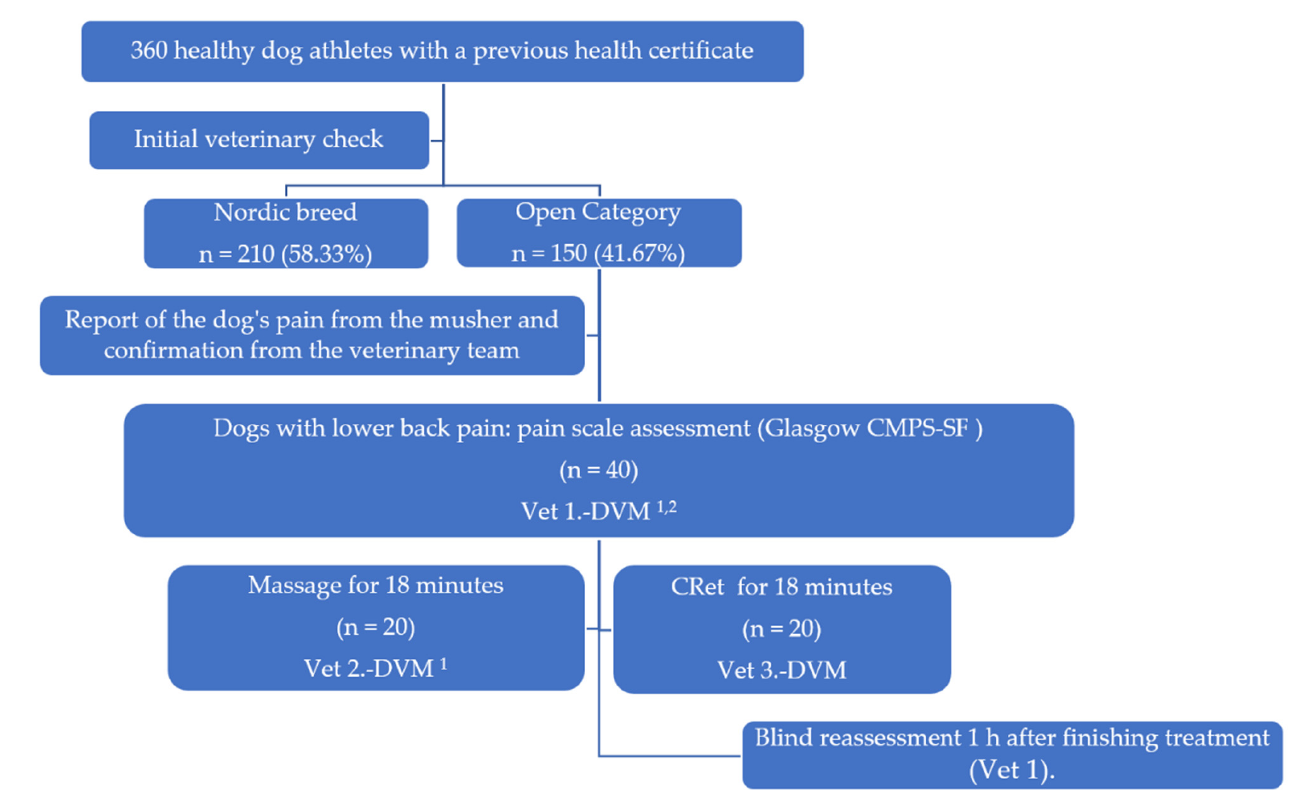
Figure 2. Study Flow Diagram: 1 Diploma certified by École Nationale Vétérinaire d’Alfort (France); 2 Osteopathic veterinarian certified by IMAOV (France).